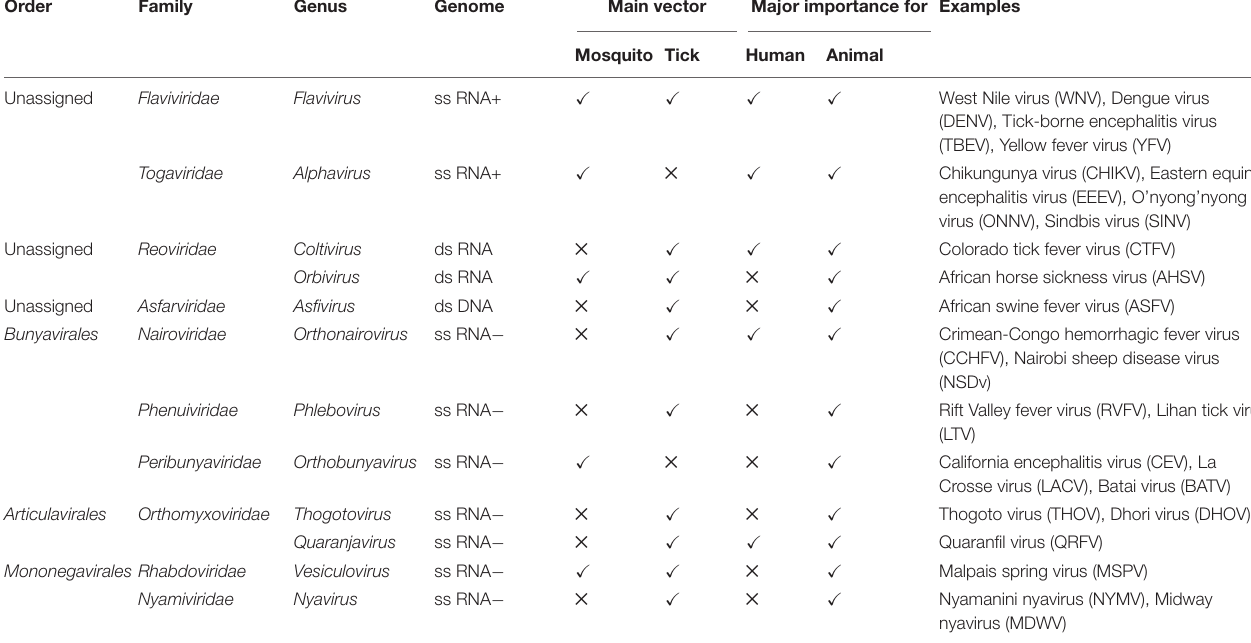
TABLE 1 | List of arbovirus families transmitted by mosquitoes and ticks.